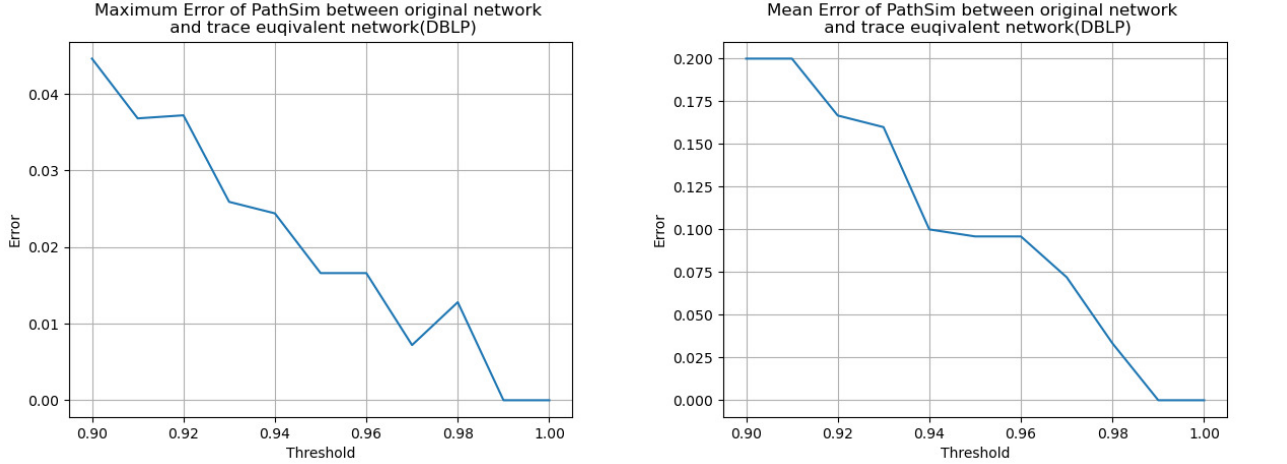
Figure 7. Trend of maximum error ( Left ) and mean error ( Right ) of PathSim on DBLP between original network and trace-equivalent